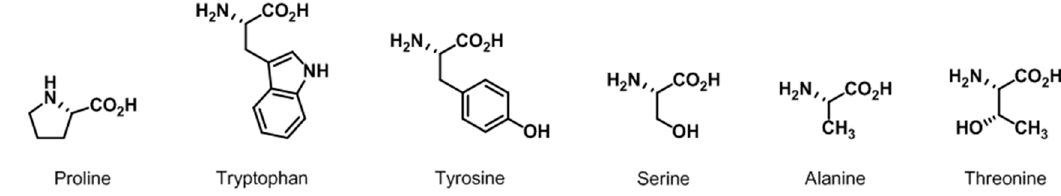
Figure 1. Three categories of chiral pool use in asymmetric synthesis.